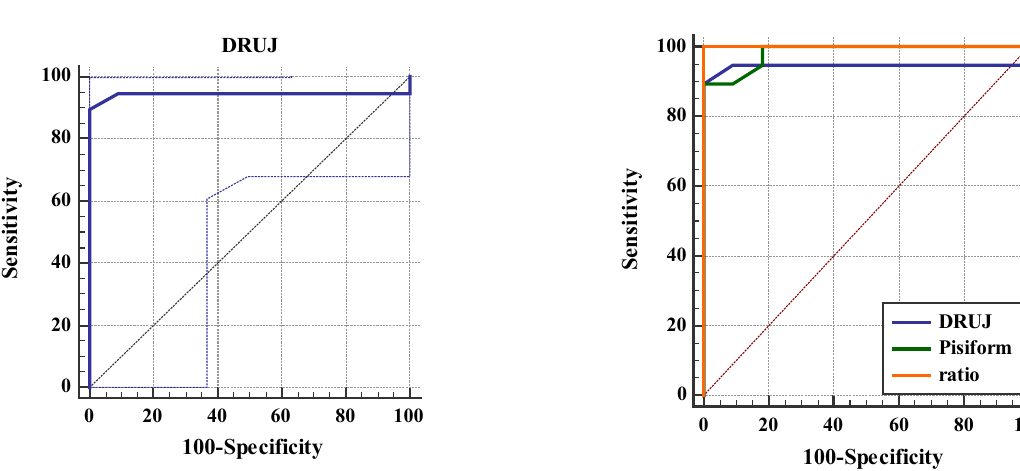
Fig. 8 Pairwise comparison of the area under the curves for DRUJ and pisiform ADCs and the ADC